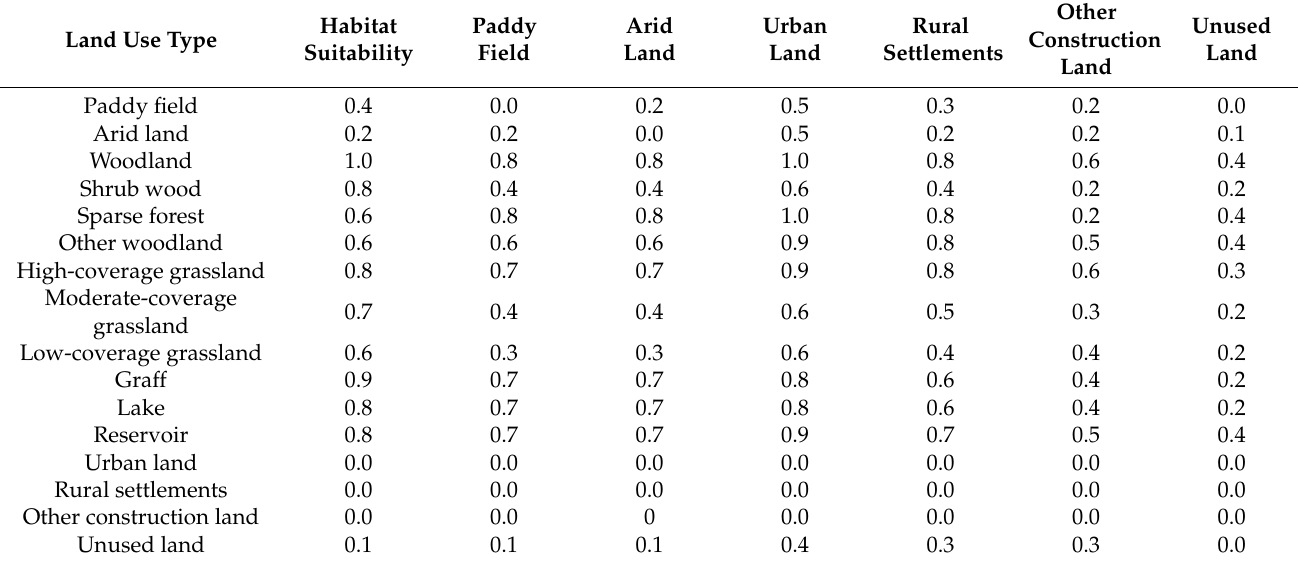
Table 3. Habitat suitability degree and sensitivity to threats of land use